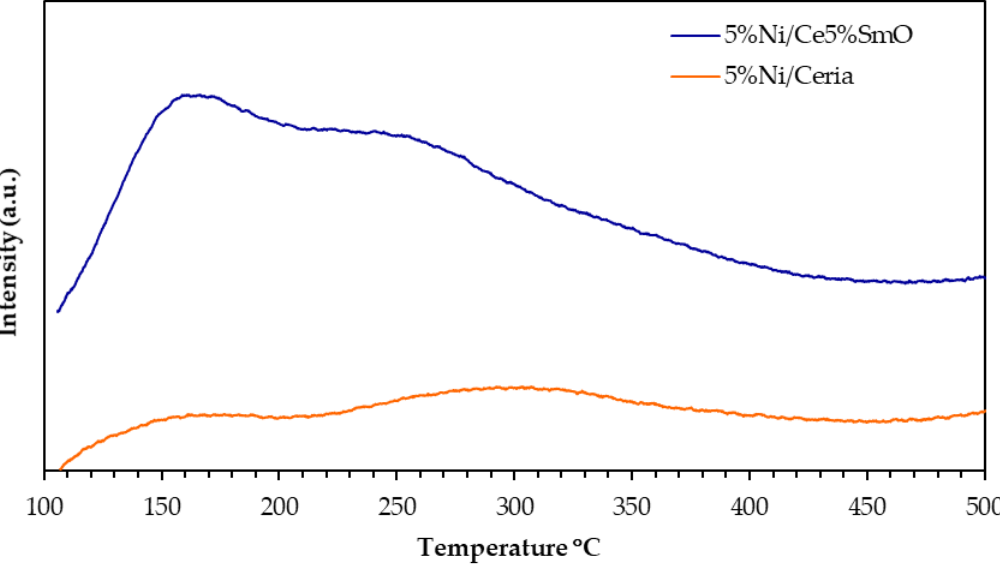
Figure 9. Temperature programmed NH 3 desorption profile of 5%Ni/CeO 2 and 5%Ni/Ce5%SmO catalysts prepared by combustion method.